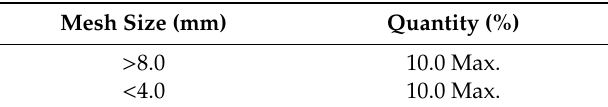
Table 4. Granulometric analysis.